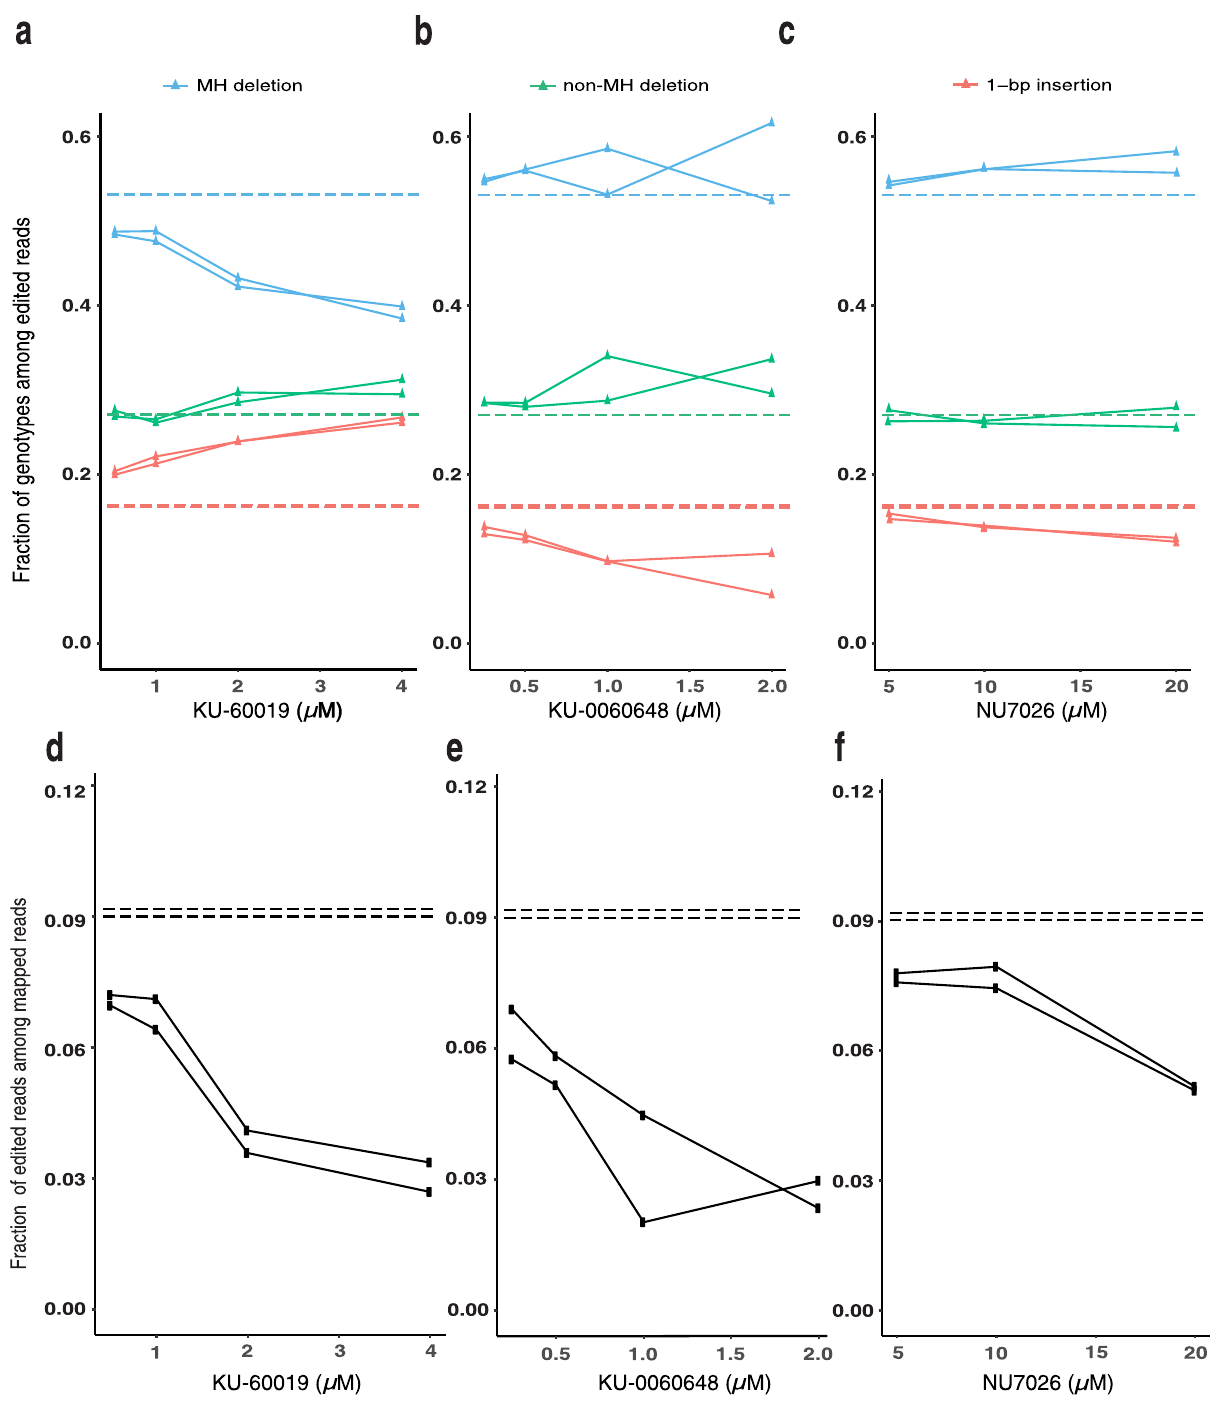
Fig. 2 KU-60019 induces dose-dependent increases in 1-bp insertion outcomes in mESC. Fraction of 1-bp insertion, MH deletion, and non-MH deletions among all SpCas9-NG-edited reads at different µ M concentrations for a KU-60019, b KU-0060648, or c NU7026. Fraction of SpCas9-NG-edited reads among the total mapped reads for mESC with 48-site library treated with DMSO (horizontal line), KU-60019 ( d ), KU-0060648 ( e ), or NU7026 ( f ) at different μ M concentrations as noted. Each plot shows the 48-site library averaged genotype fraction, N = 2 biologically independent samples. The horizontal dashed lines mark the DMSO genotype fraction for either replicate, respectively. The solid lines mark the genotype fraction for each experimental replicate, respectively and closely